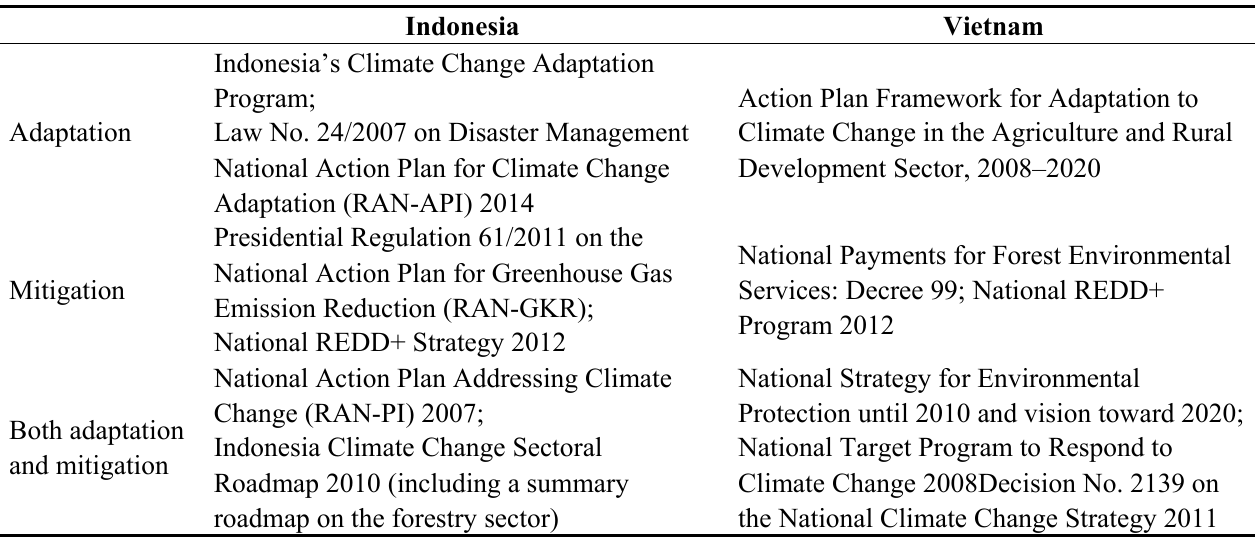
Table 1. Key mitigation and adaptation policies in Indonesia and Vietnam.